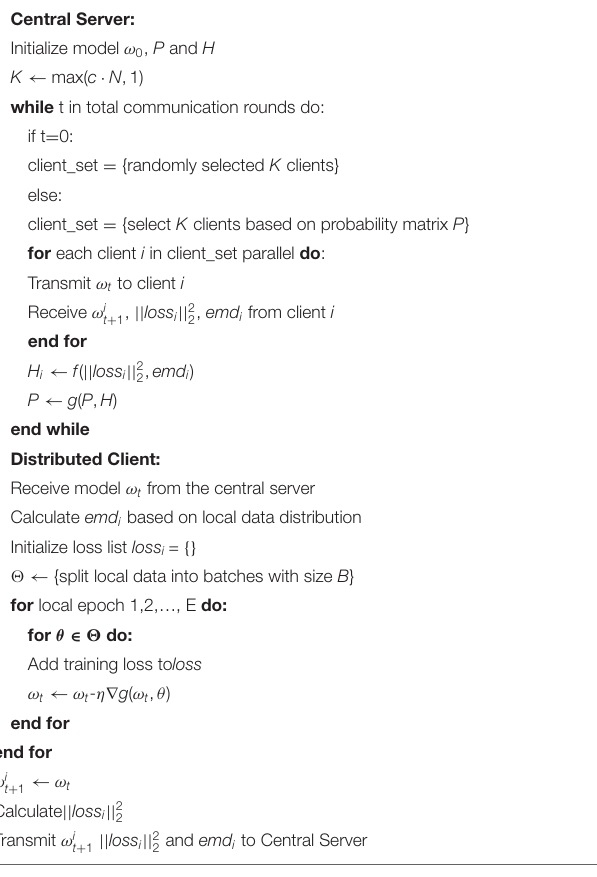
Algorithm 1 : Adaptive client selection enabling federated learning (ACSFed). K clients are selected from N clients with fraction c ; η is the learning rate, P is the probability matrix; H is the cumulative model strength matrix.